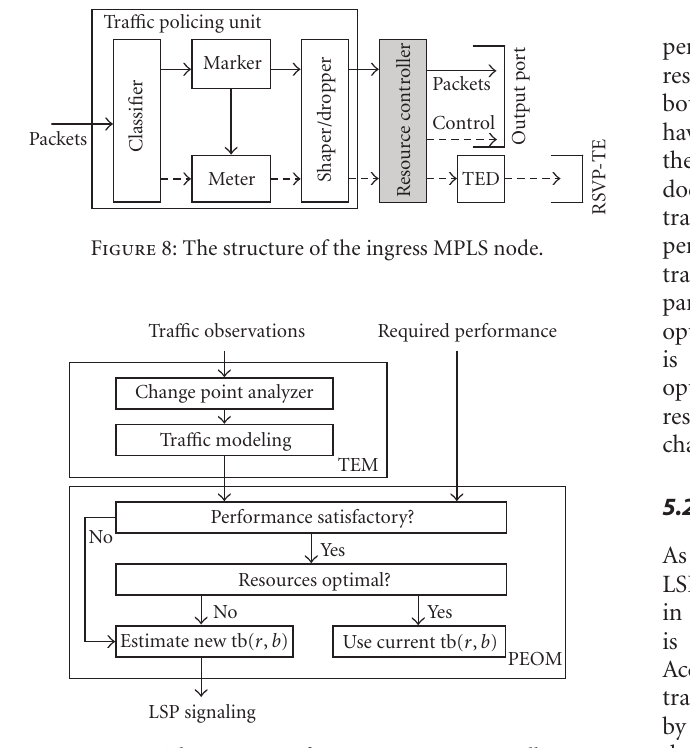
Figure 9: The structure of EWMA resource